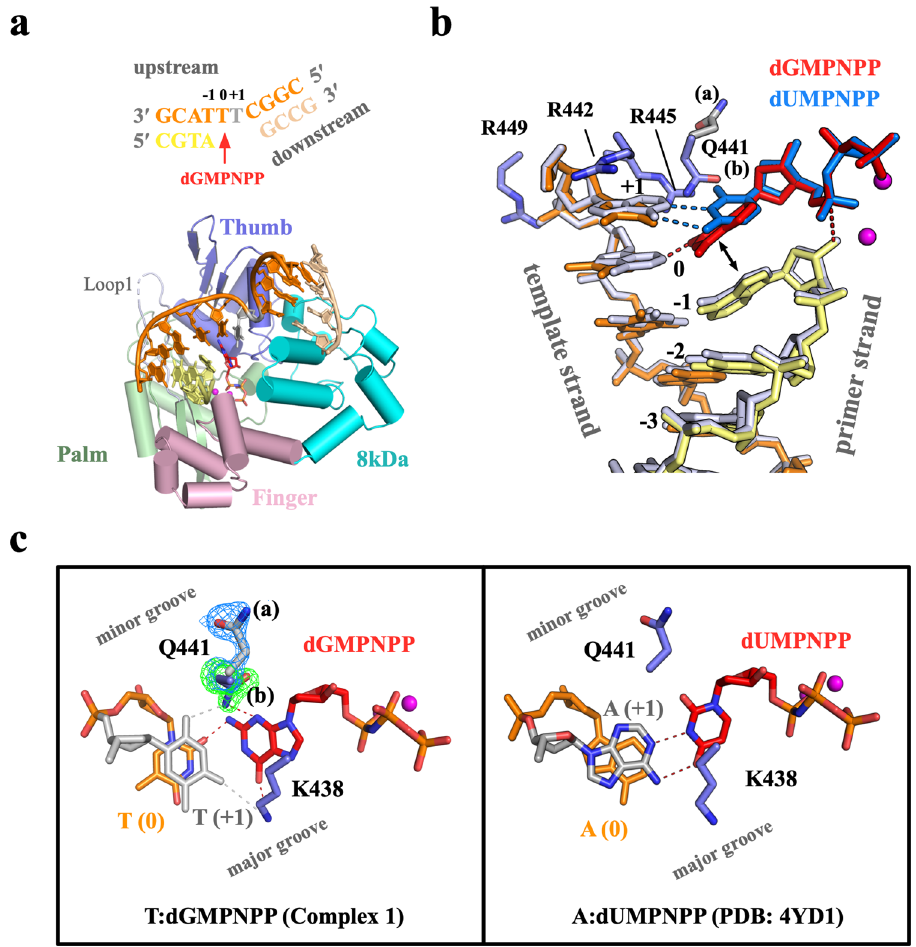
Fig. 2 Structure of dGTP misincorporation on a 2-nt gapped DNA substrate (Complex 1). a Overall structure of Pol μ complexed with 2-nt gapped DNA and dGMPNPP. A schematic of the DNA substrate used for crystallization is shown on top with colors corresponding to those in the structures below. Protein domains of Pol μ are labeled and shown in distinct colors. Two catalytic Mg 2 + and the largely disordered Loop1 region are colored magenta and gray, respectively. The dGMPNPP is shown as a stick (red). b Superposition of misincorporation (Complex 1) and correct insertion (PDB: 4YD1) structures of Pol μ complexed with 2-nt gapped DNA. Complex 1 is colored and labeled as in ( a ). The surrounding Arg residues and Gln441 containing two conformations are labeled and shown as sticks. The published structure is colored white with the dUMPNPP in blue. The double arrowhead indicates the stacking between dGMPNPP and 3 ʹ -end dA. Hydrogen bonds are indicated by dashed lines. c Top views of correct (A:dUMPNPP) and incorrect (T: dGMPNPP) nascent base pairs in ( b ). Lys 438 and Gln441 are shown as sticks. Incoming nucleotides and + 1 and 0 templating bases are labeled and colored red, white, and orange, respectively. Two conformations of Q441 are superimposed with the 2Fo – Fc (blue; contoured at 0.8 σ ) and Fo – Fc omit map (green; contoured at 3.0 σ ), which were calculated without the conformation